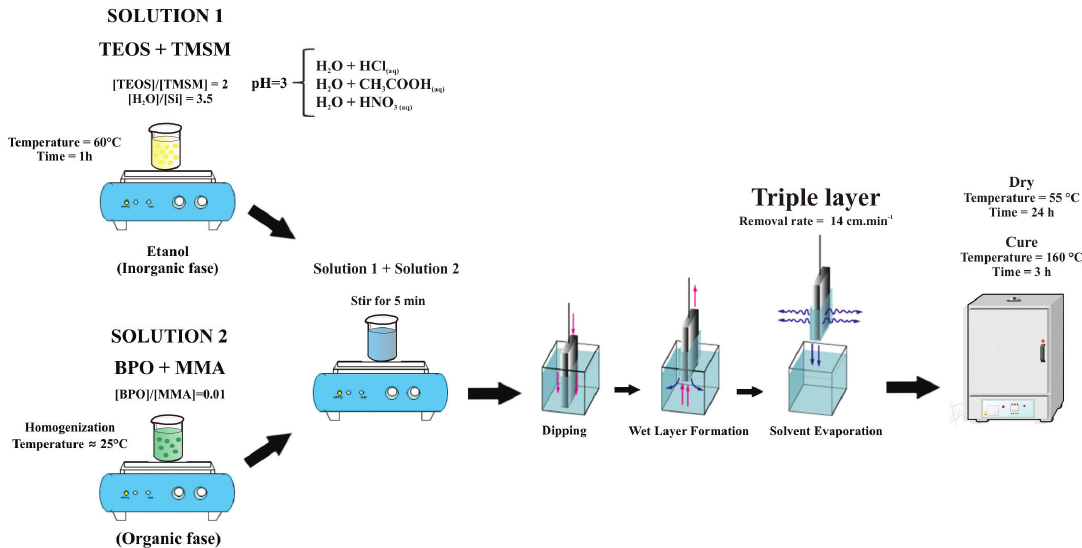
Figure 2. Flowchart of samples